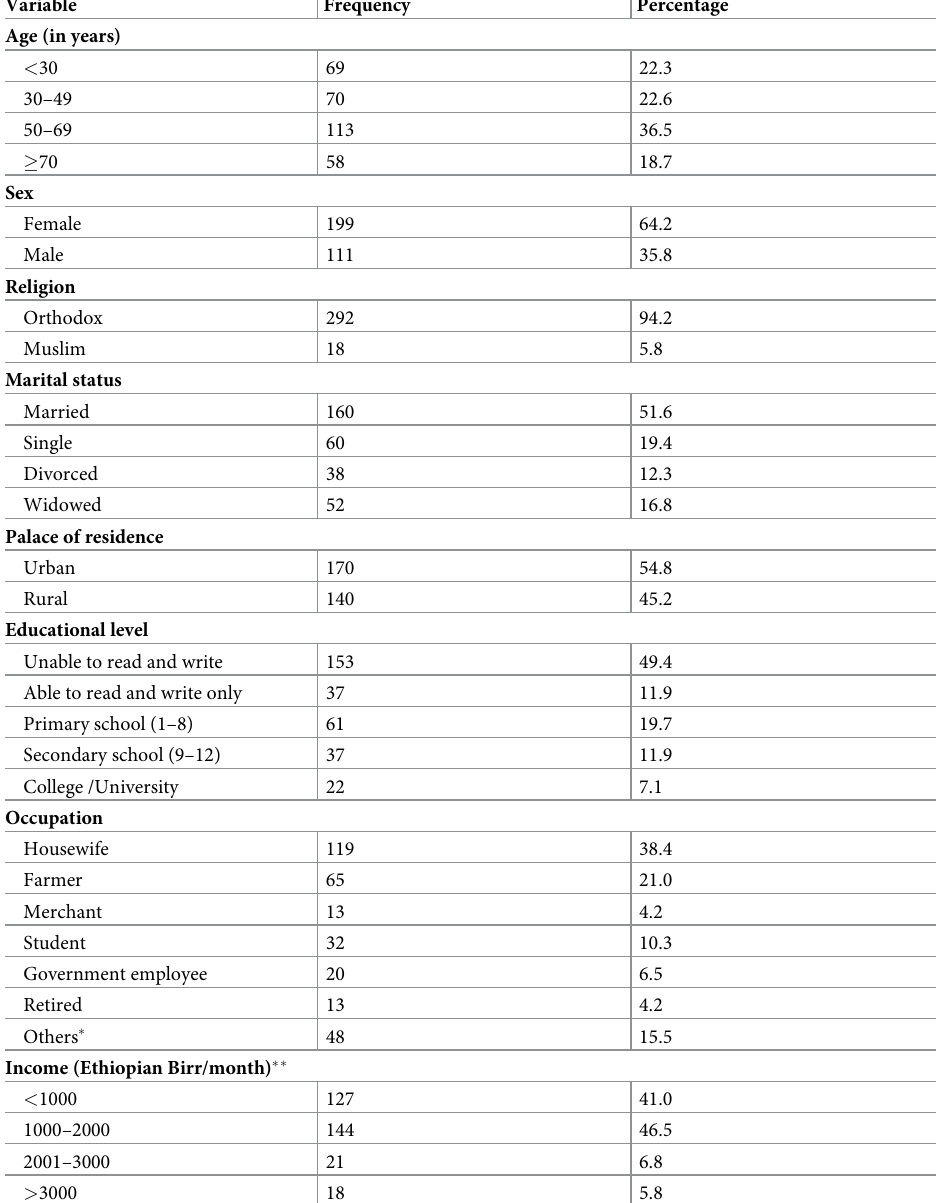
Table 1. Socio-demographic and economic characteristics of heart failure patients, Gondar University referral hospital, Northwest Ethiopia, May 2017 (n =